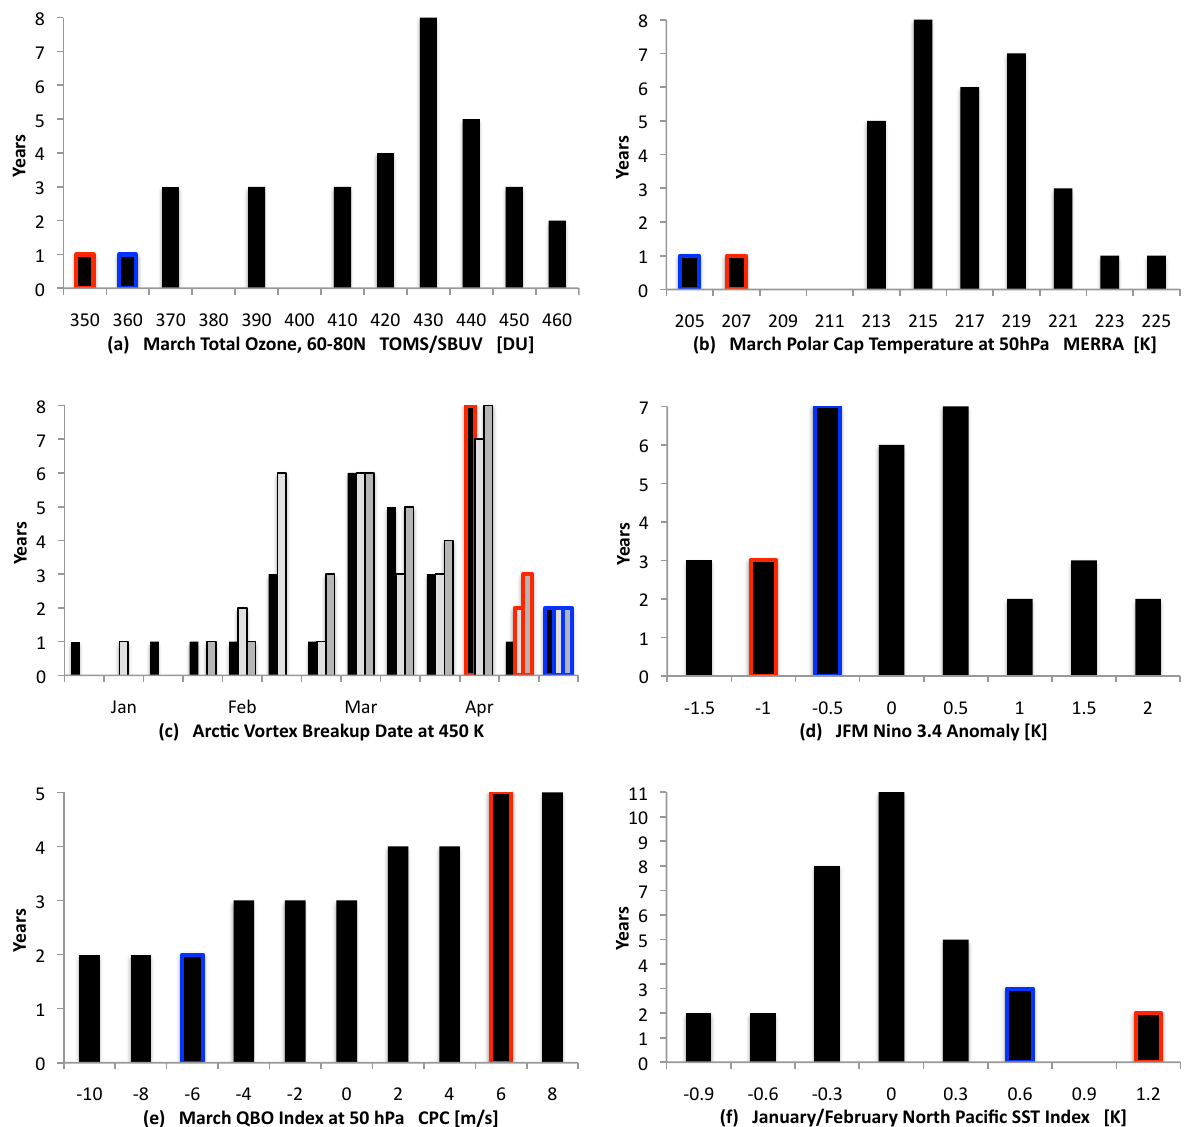
Fig. 1. Histograms of total ozone and dynamical conditions during the 1979–2011 period: (a) March total ozone averaged between 60– 80 ◦ N [DU]; (b) March Arctic polar cap temperature at 50hPa [K]; (c) Date of the Arctic vortex breakup at 450K based on the NCEP-2 (black), NCEP-1 (light gray) and CPC (dark gray) reanalyses, binned into 10-day intervals; (d) January-February-March SST anomaly in the Ni˜no 3.4 region [K]; (e) March zonal winds in the equatorial region at 50hPa [ms − 1 ]; (f) January/February SST anomaly in the 40–50 ◦ N, 160–200 ◦ E region [K]. Red (blue) outlines indicate the location of 2011 (1997) conditions. X–axis values indicate the mid-point of each histogram